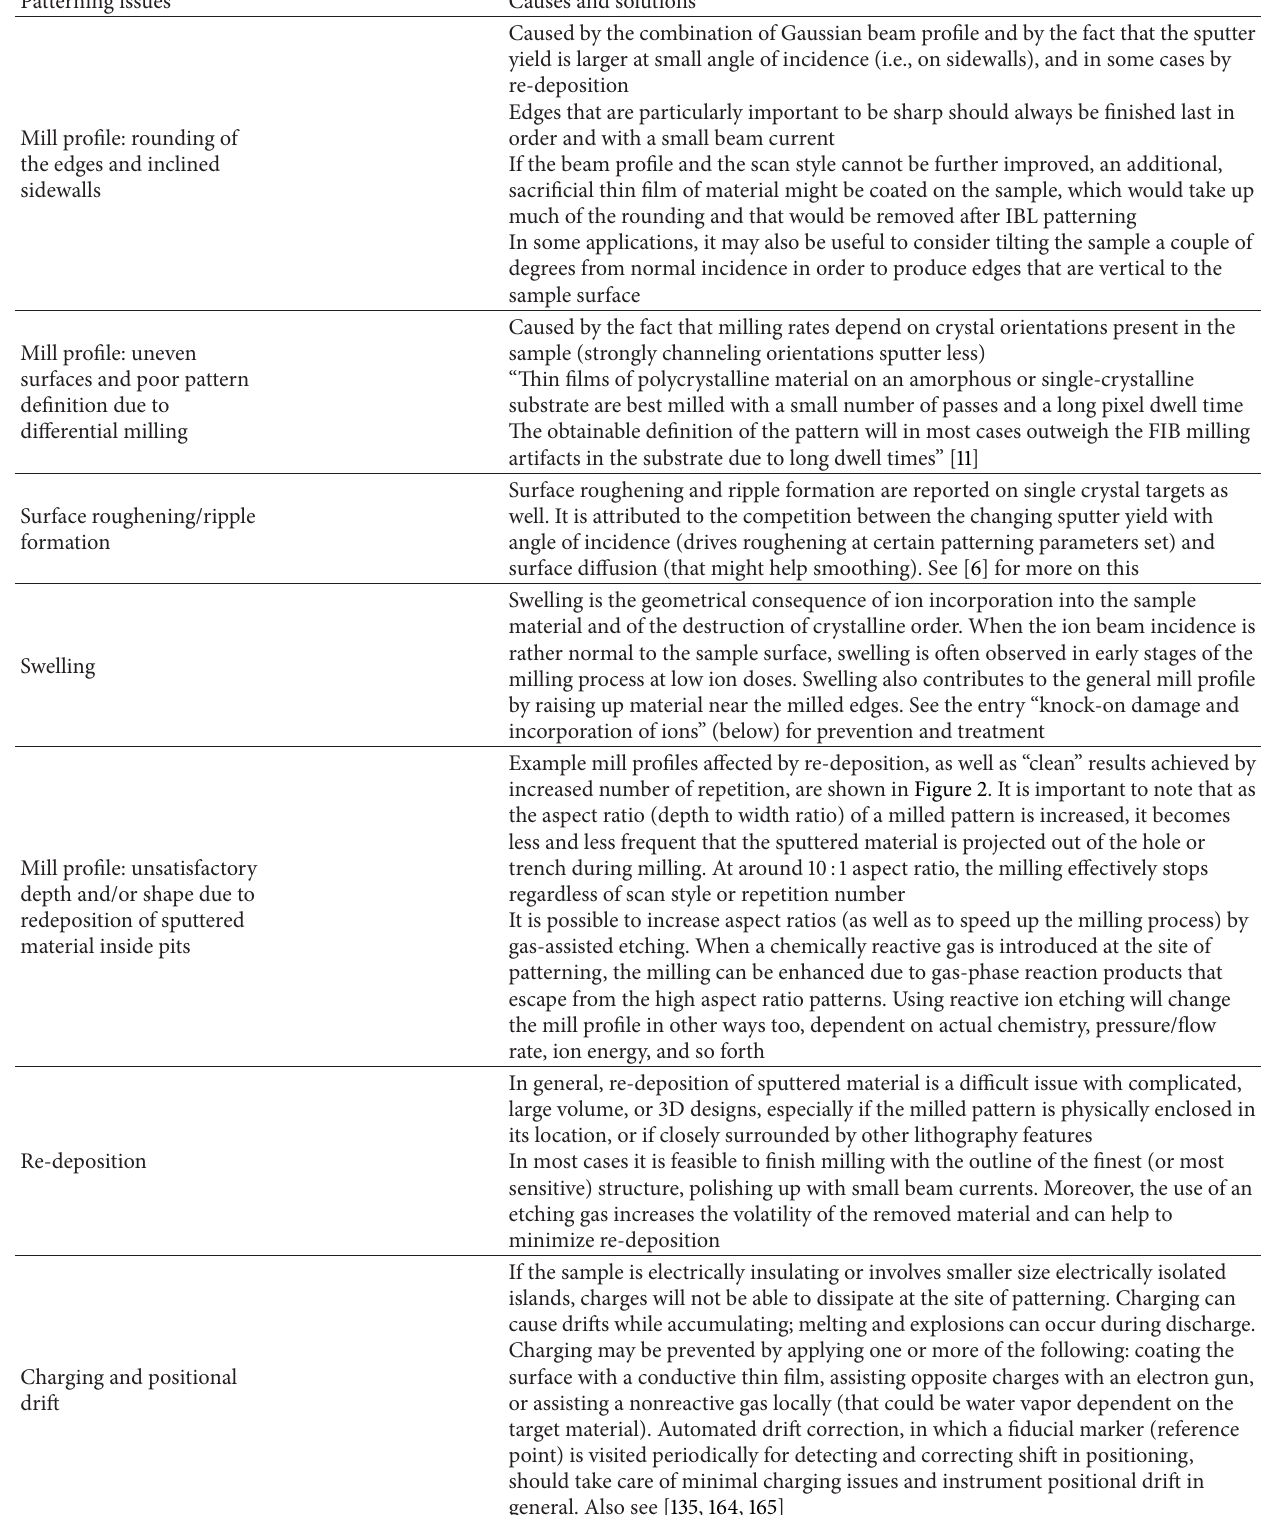
Table 5: Patterning issues and strategies to deal with